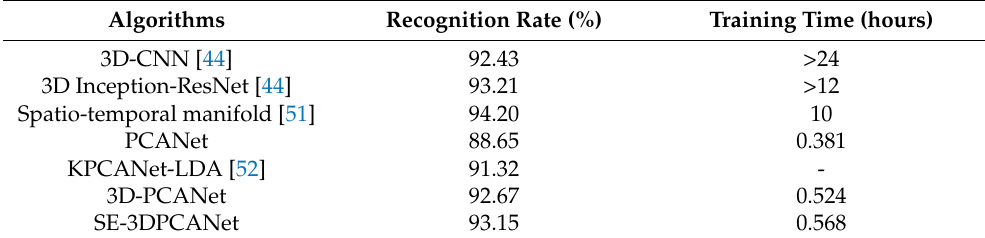
Table 1. Performance comparison of different algorithms on the CK+ dataset.